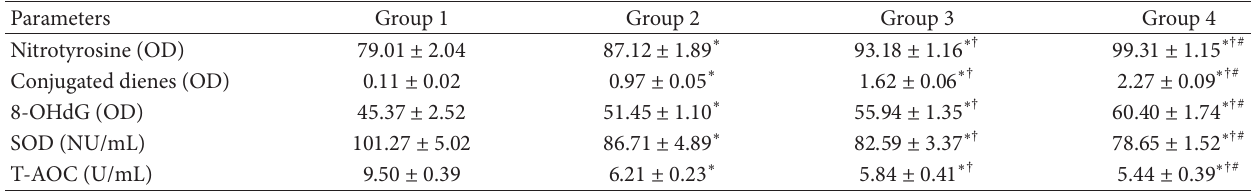
T 2: Comparison of markers of oxidant and antioxidant (